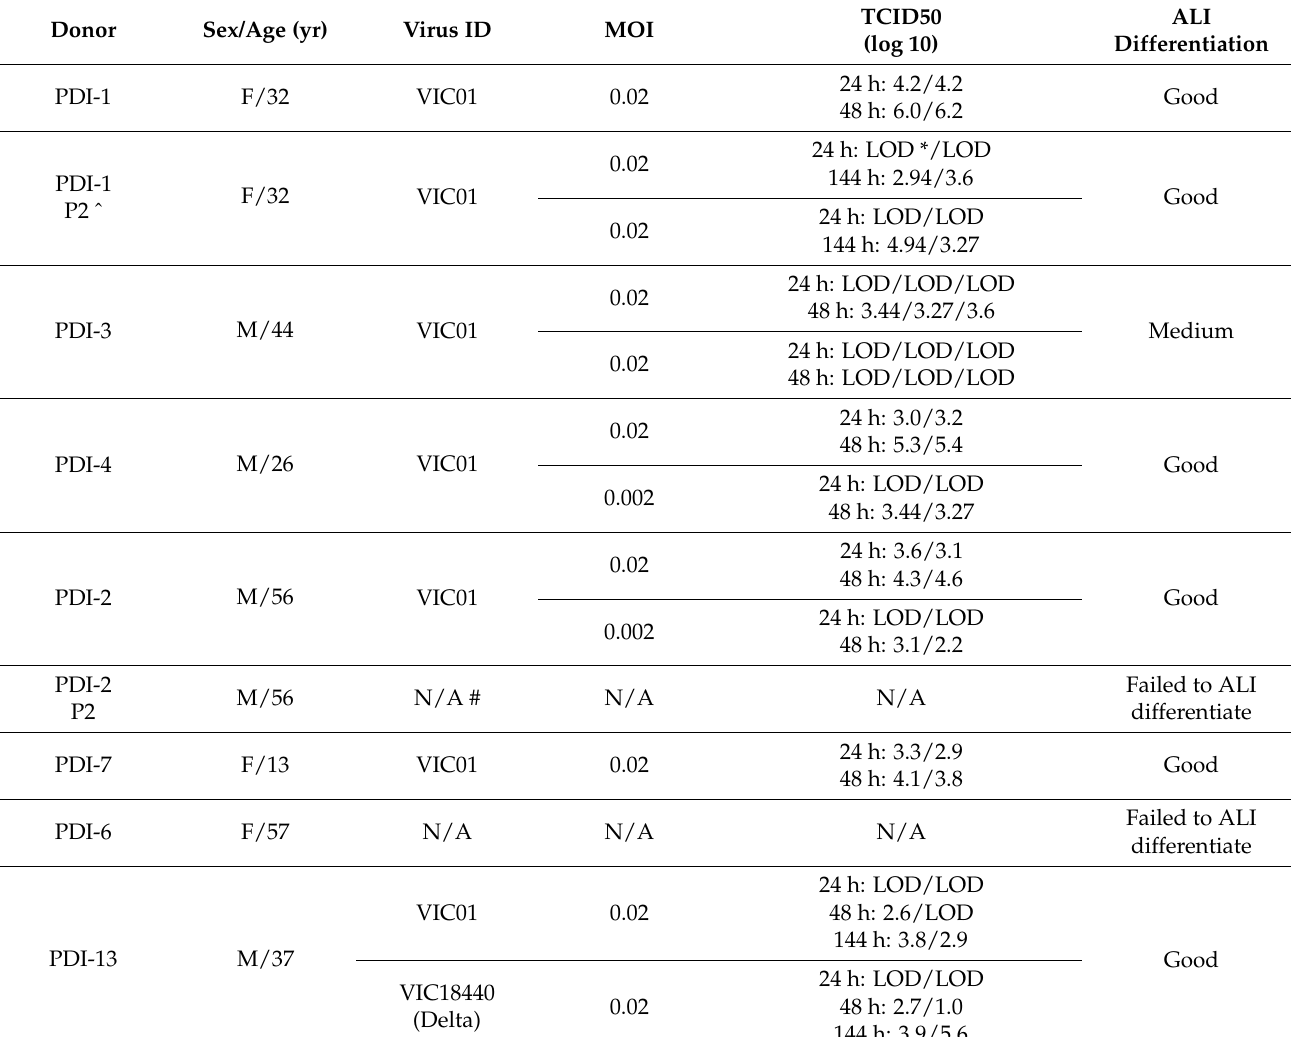
Table 1. SARS-CoV-2 infection of